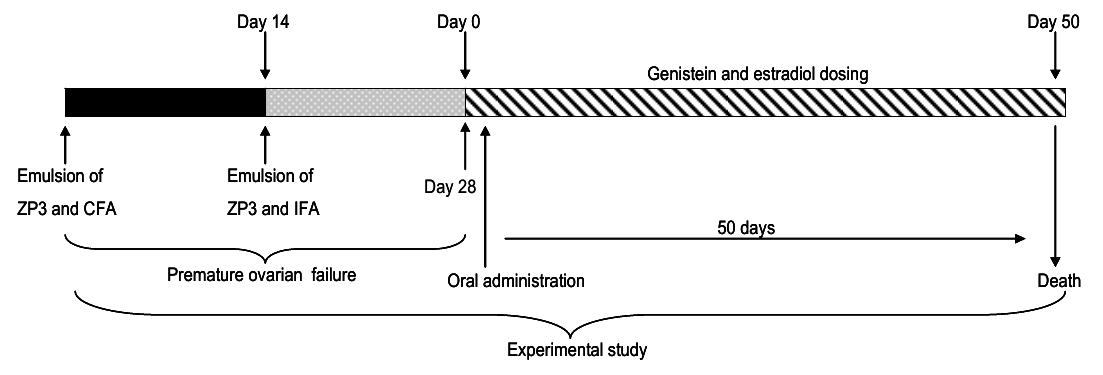
Figure 4. Schematic illustration of experimental design.